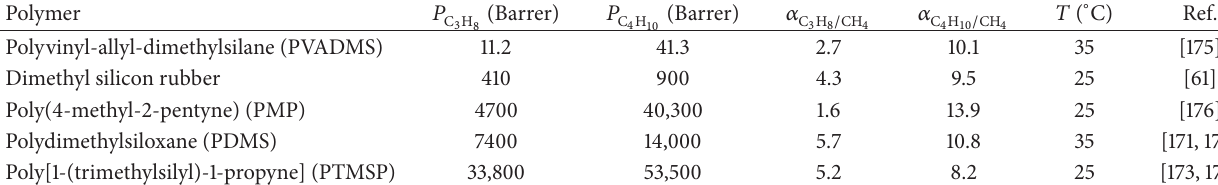
Table 15: Performance of polymeric membranes for LPG